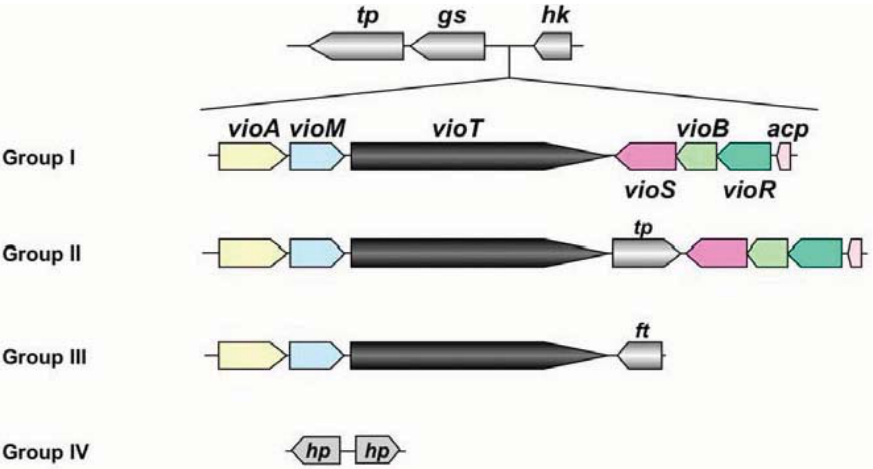
Figure 4. Gene cluster in the viosamine island in several pathovars of P. syringae . The genomic regions corresponding to viosamine islands from pathovars and strains from P. syringae were classified into four groups. Group I contains those from pv. tabaci 6605, pv. tabaci ATCC 11528, pv. glycinea race 4, pv. glycinea B076, pv. savastanoi NCPPP 3335, pv. phaseolicola 1148A, and pv. aesculi 2250 and NCPPB 3681; Group II contains those from pv. tomato DC3000, T1, Max 13, and NCPPB 1108; Group III contains those from pv. syringae 642; and Group IV contains those from pv. syringae B728a and FF5 and pv. oryzae 1_6. The following abbreviations are used: tp : major facilitator family transporter; ft : folate-dependent phosphoribosylglycinamide formyltransferase PurN; hp : hypothetical protein. Other gene names are indicated in the legend of Figure